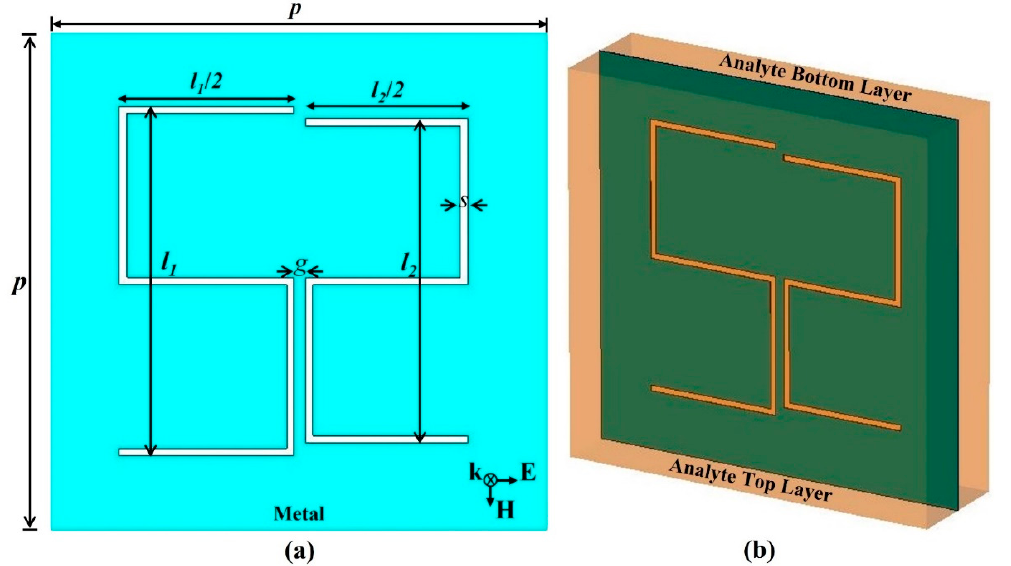
Figure 1. ( a ) Unit cell dimensions of the asymmetric S-shaped complementary resonator with the related dimensions. ( b ) Three-dimensional representation showing the glucose sample top and bottom layers. The inset of part ( a ) illustrates the field polarization.